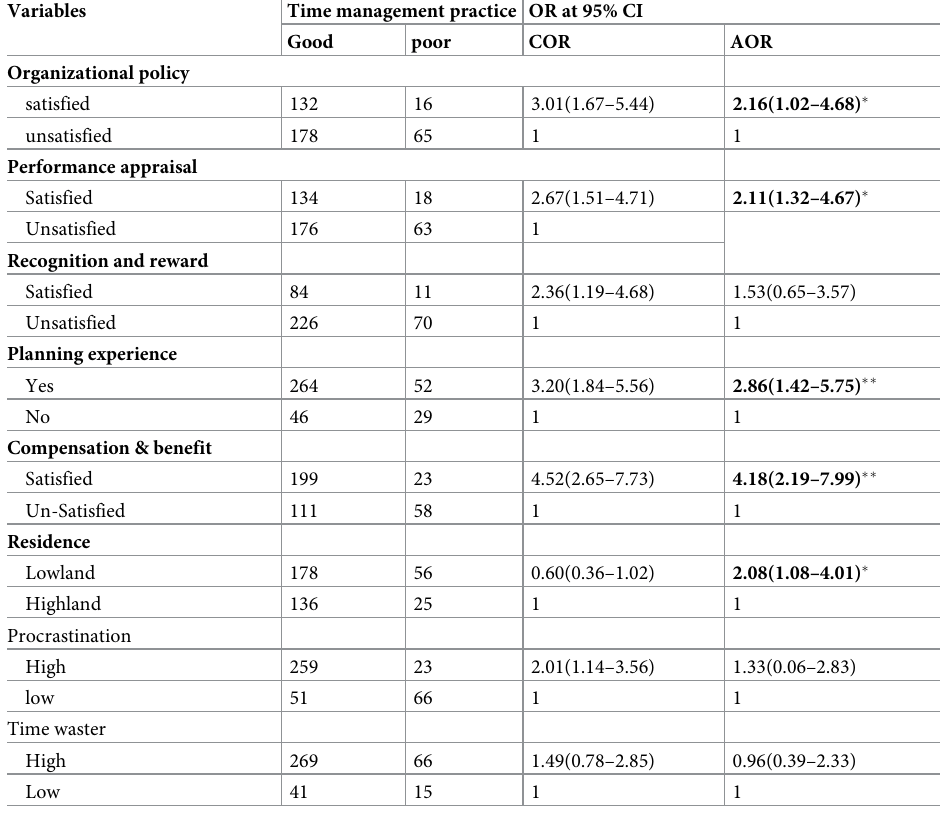
Table 3. Bivariate & multivariate logistic regressions of factors associated with time management practices among primary hospital employees of North Gondar from March to April, 2017 (n = 391).